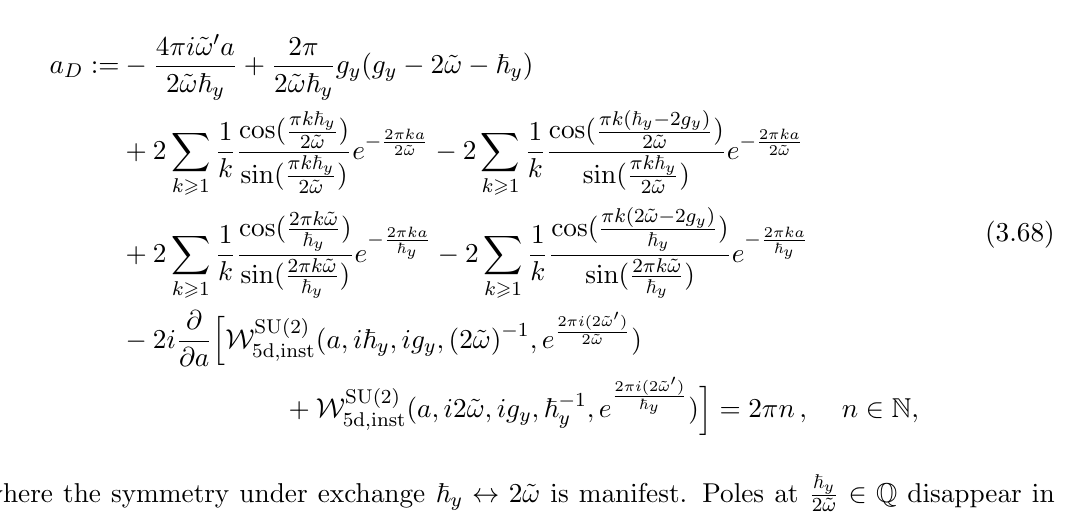
Table 10 . Gauge theory energies for the 2-eRS A model (3.12) at g y = the na(cid:127)(cid:16)ve WKB quantization conditions